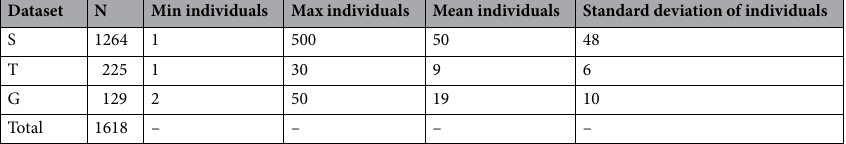
Table 4. Dataset description. N represents the number of sightings for each dataset; the minimum, maximum, mean, and standard deviation of the number of individuals recorded for each species are reported. S represents striped dolphin, T refers to common bottlenose dolphin and G to Risso’s